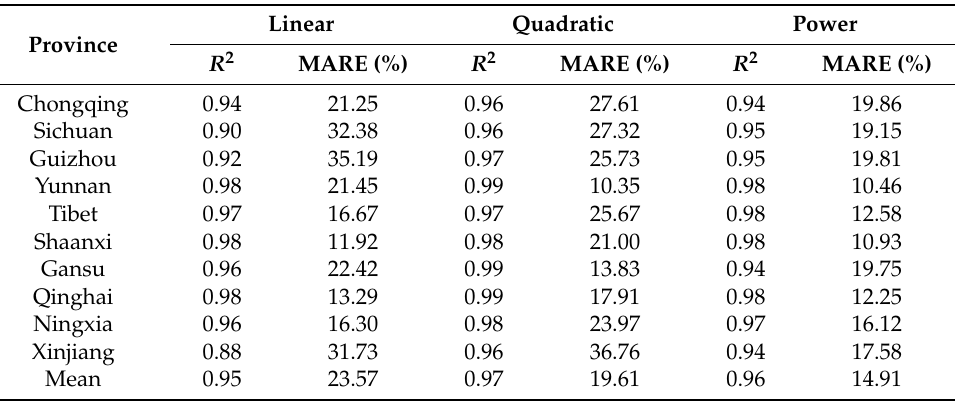
( c ) Figure 6. Optimal models of the relationship between the statistical GDP data and TNL for different provinces: ( a ) the linear model for Hubei; ( b ) the quadratic polynomial model for Gansu; ( c ) the power function model for Guangdong.